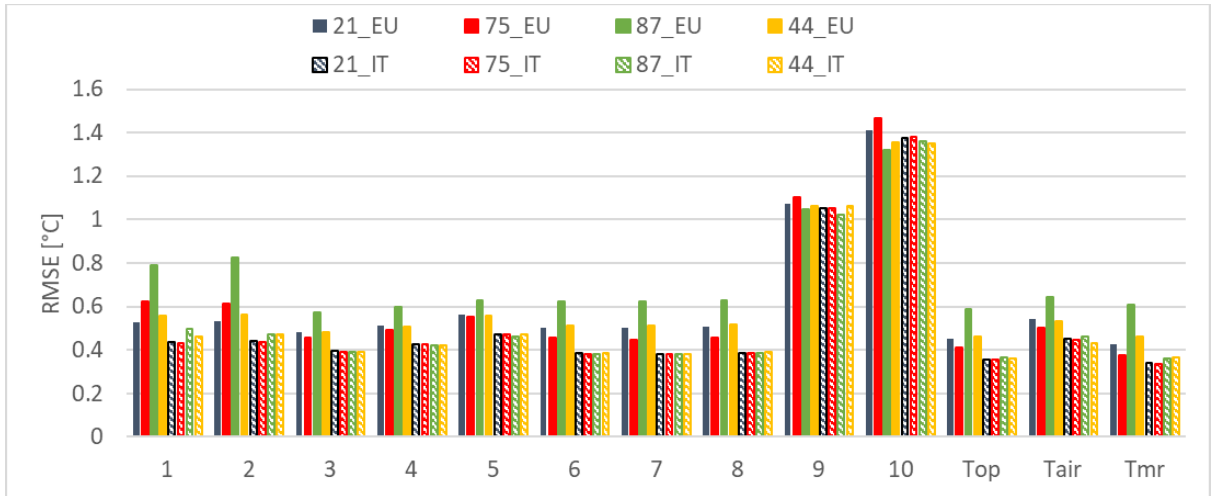
Figure 9. RMSE [°C] calculated for indoor and surface temperatures in the living room. (EU: Annex B, IT: Annex A).